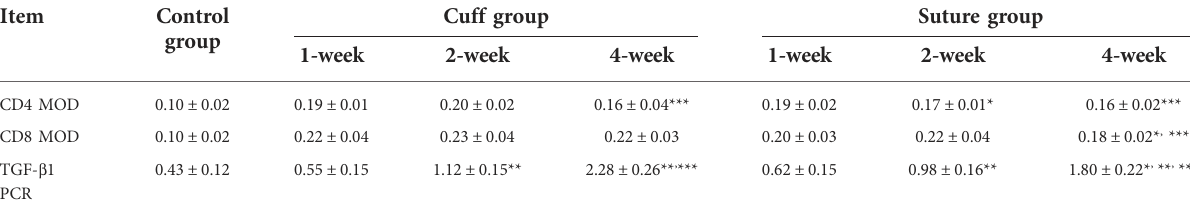
*Indicates P <0.05 compared with rats in the cuff group. **Indicates P <0.05 compared with rats in the 1-week group. ***Indicates P <0.05 compared with rats in the 2-week